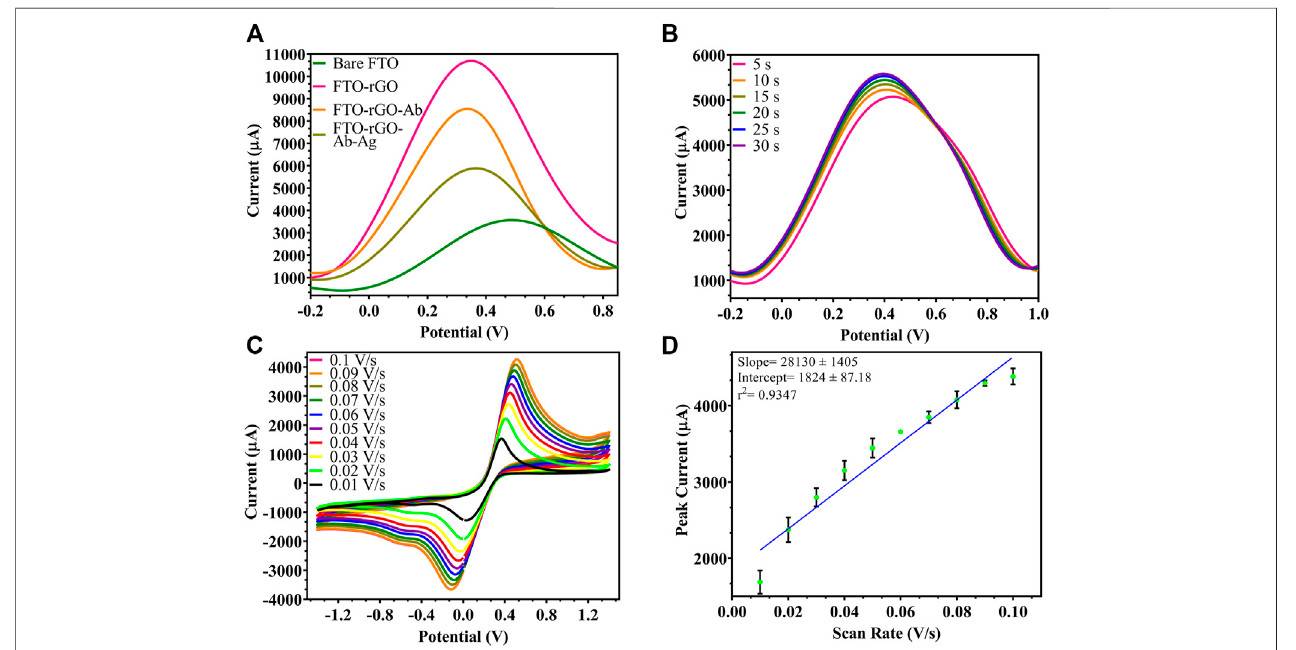
FIGURE 3 | Characterization of the fabricated electrode: (A) DPV spectra of fabrication stages, uncoated FTO (3,567 μ A), rGO-coated FTO (10696 μ A), rGO- BACE1Ab-coatedFTO(8,546 μ A),AgcapturedbyrGO-BACE1Ab-coatedFTO(5,884 μ A); (B) DPVoffabricatedelectrodewhereresponsetimewastestedfrom5 sto 30 s,and5 sandbeyondshowedstablereadings; (C) CVofelectrodewherescanratewasrangedfrom0.01to0.1 V/sandincreaseincurrentwasobserved; (D) linear regression of peak current vs. scan rate.